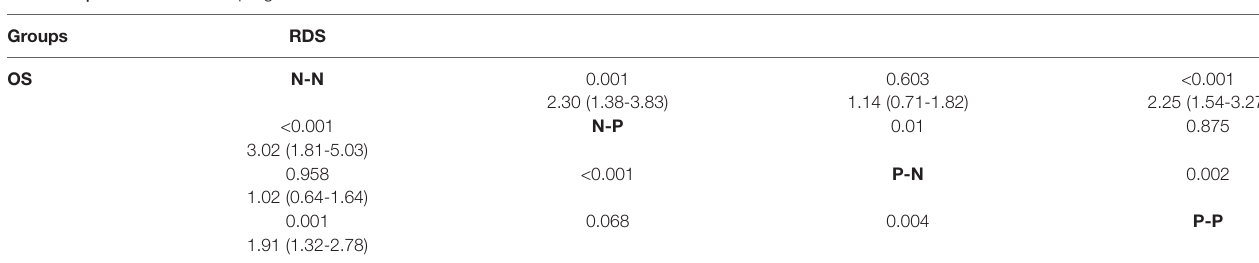
TABLE 5 | The association of prognostic data with AFP alteration. Groups